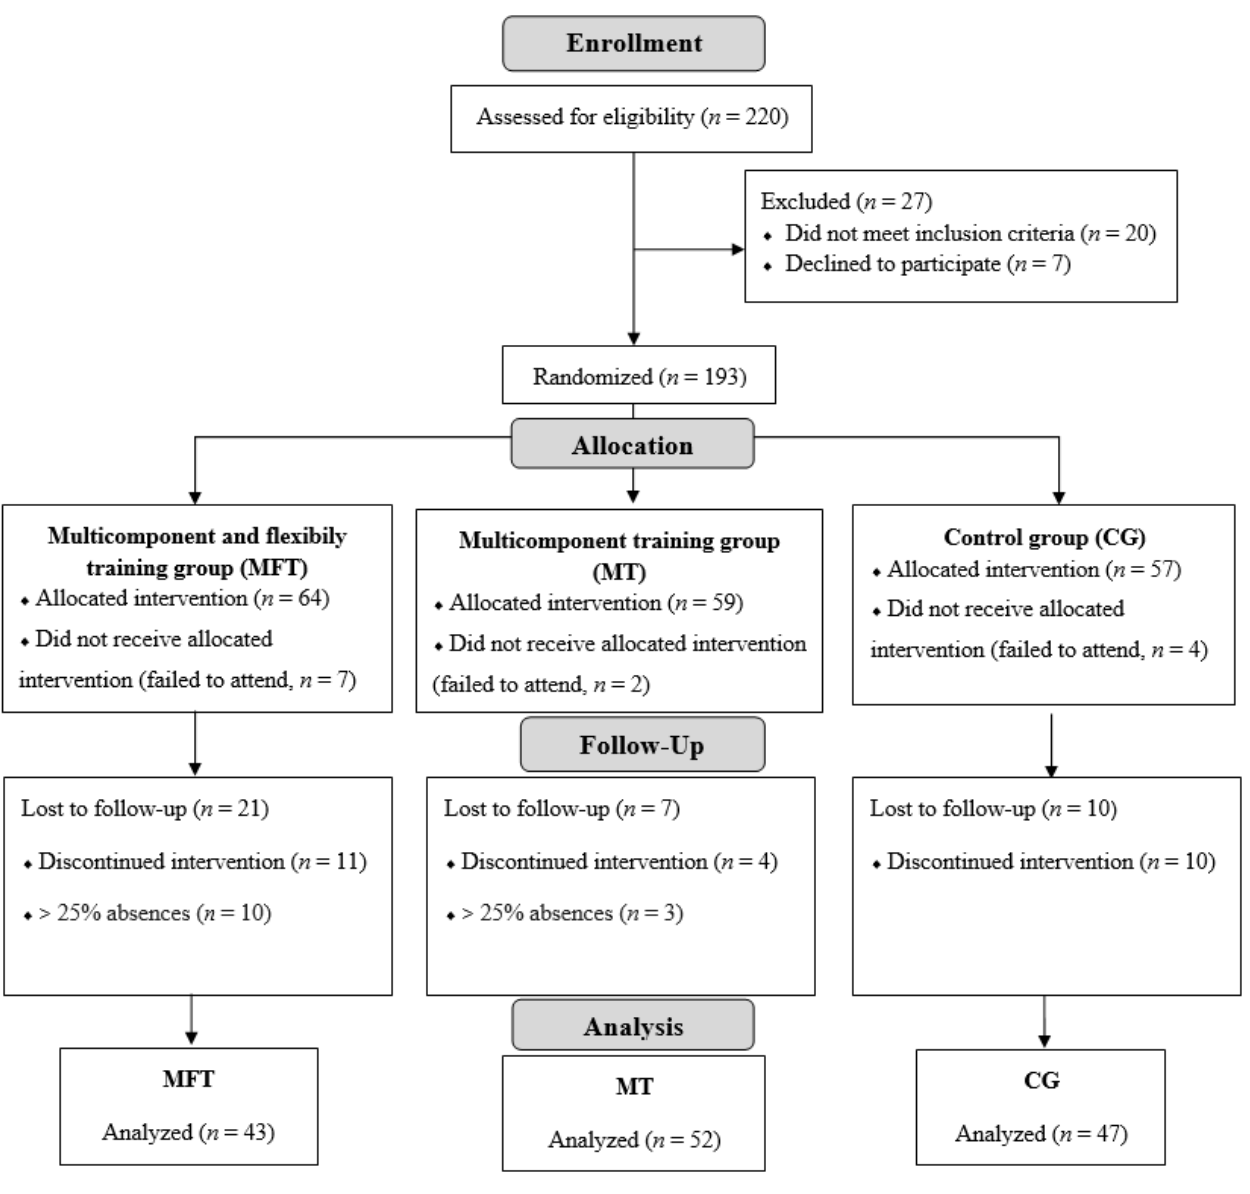
Figure 2. CONSORT flow diagram.